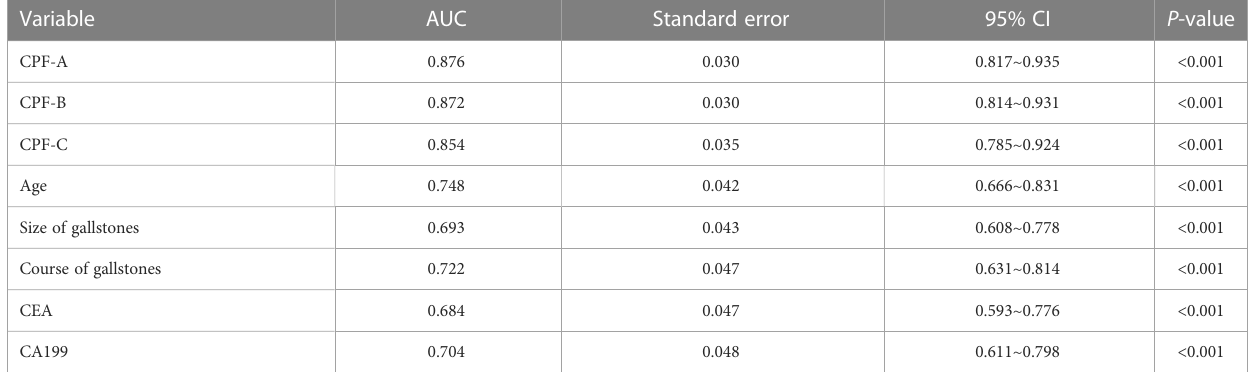
TABLE 7 Predictive values of predictive factors associated with GBC in the external validation